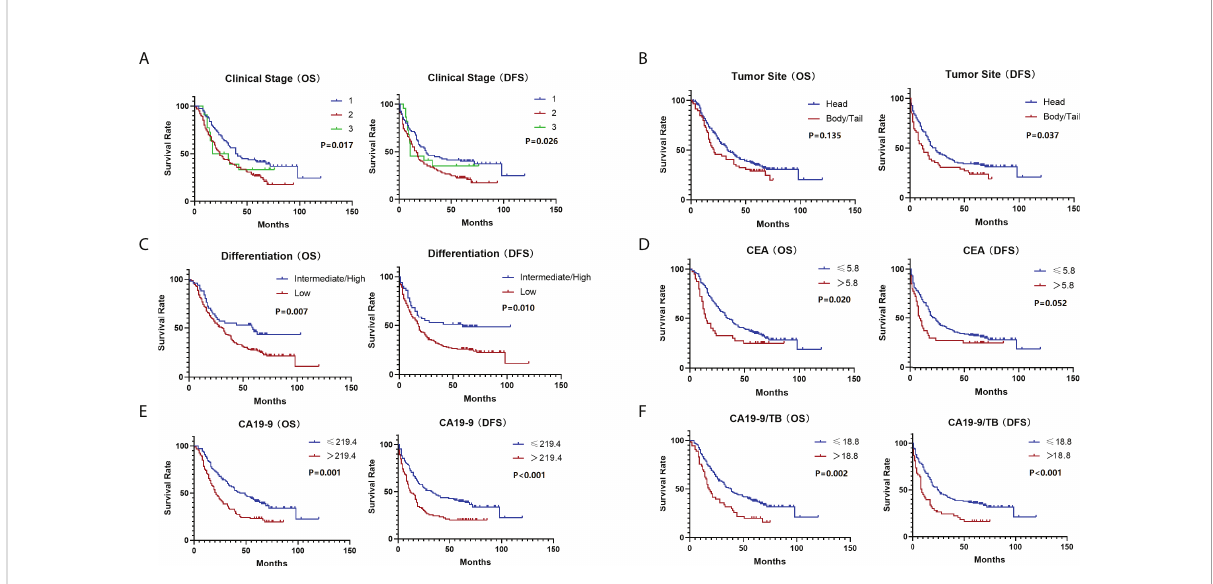
FIGURE 2 The survival curves (OS & DFS) of the indicators after primary screening: (A) Clinical stage; (B) Tumor site; (C) Differentiation; (D) CEA; (E) CA19- 9; (F)